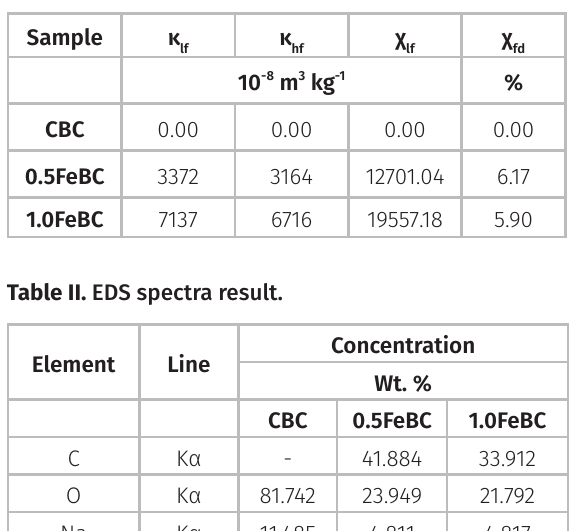
Table I. Magnetic susceptibility from biochar and biochar/γ-Fe